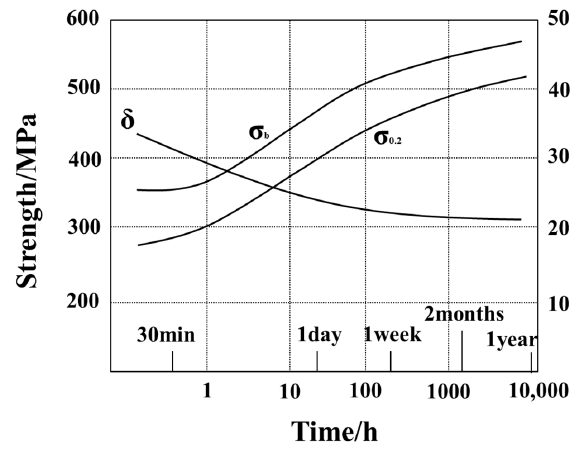
Figure 15. Mechanical properties of the Al 7XXX alloys during natural aging [116].